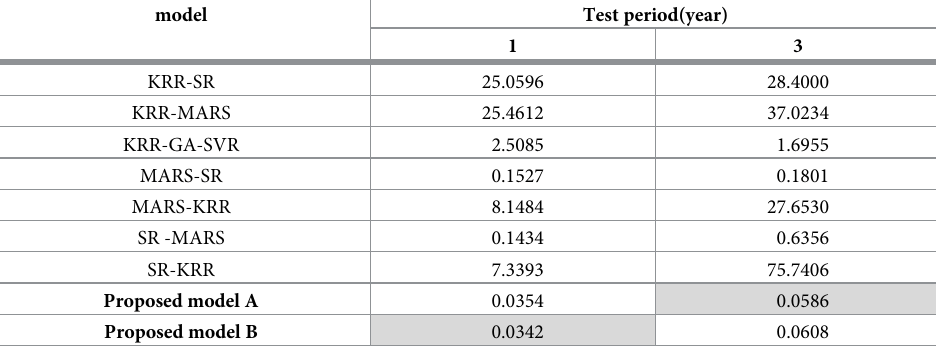
Table 8. Performance comparisons for Chunghwa